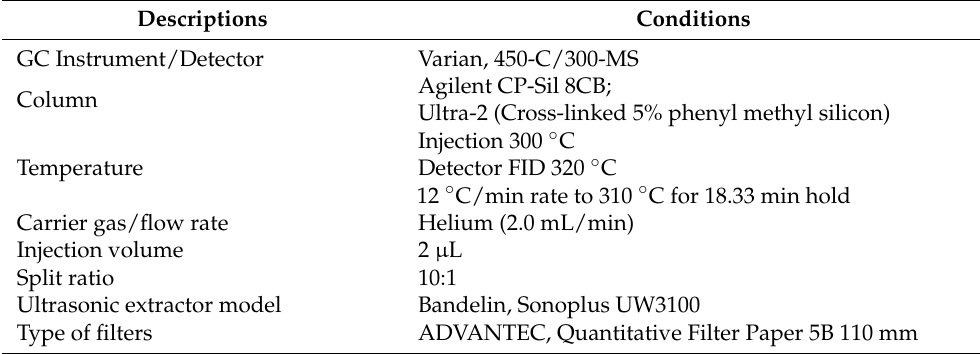
Table 6. Descriptions and conditions of gas chromatography